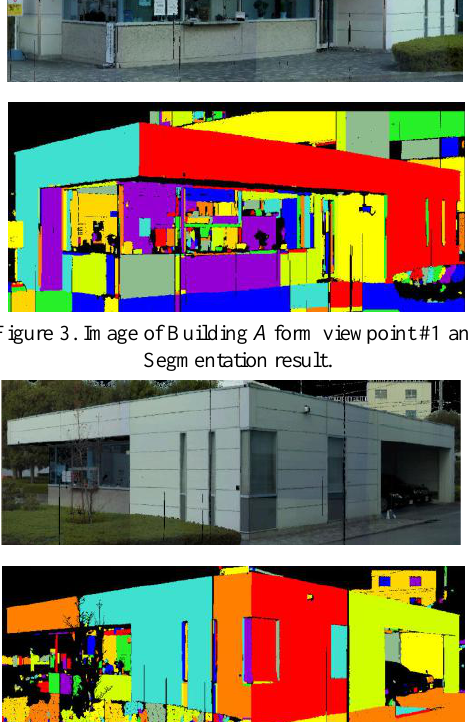
Figure 4. Image of Building A from viewpoint #2 and Segmentation